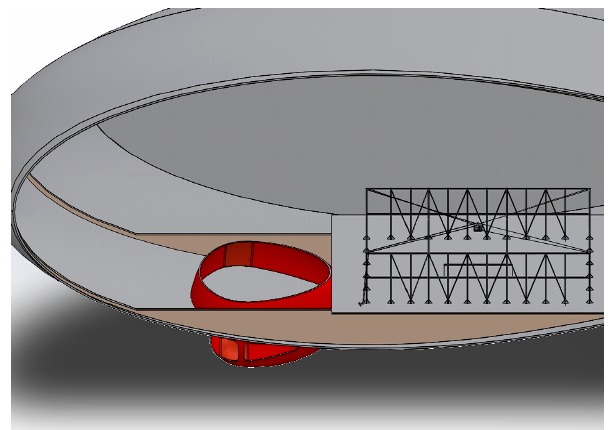
Figure 7. Positioning of the CDPM in the hold of the airship. The pulleys guiding the cables (as shown in Figure 8) are connected to controlled motors which represent the actuators of the